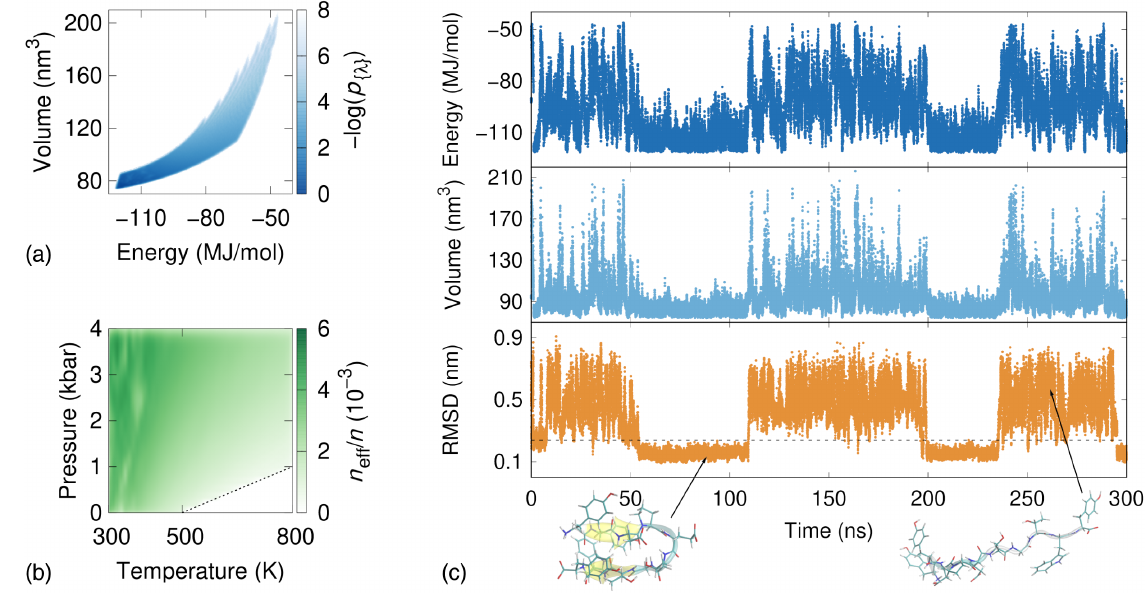
FIG. 2. Multithermal-multibaric simulation of chignolin. (a) Sampled target distribution in the CV space of potential energy and volume. (b) Relative effective sample size at different temperatures and pressures. The bottom corner of high temperatures and low pressures is excluded from the target to avoid vaporization of the system. (c) Time evolution of the two biased CVs and of the C α RMSD for one of the 40 walkers. A RMSD threshold between folded and unfolded is highlighted with a dashed line.